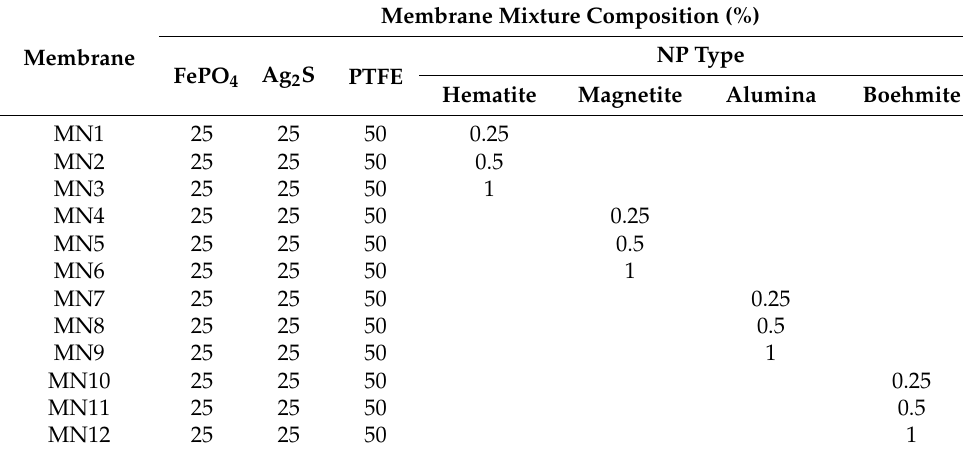
Table 3. Composition of the membranes for the determination of the ferric cation. Membrane Mixture Composition Membrane